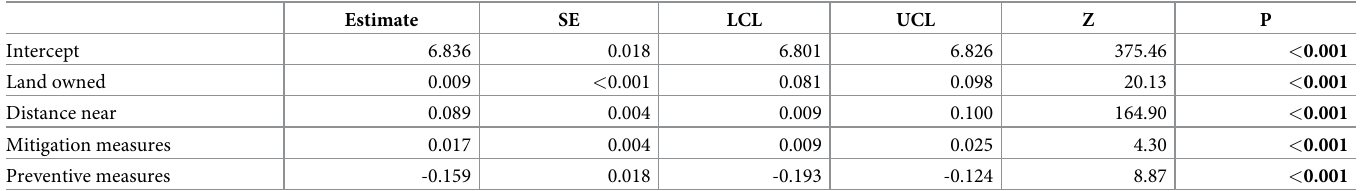
Table 3. Model-averaged parameter estimates with lower (LCL) and upper (UCL) 95% confidence limits describing crop depredations by wildlife in Shuklaphanta National Park, Nepal, 2016–2021. Significant effects are in bold font.